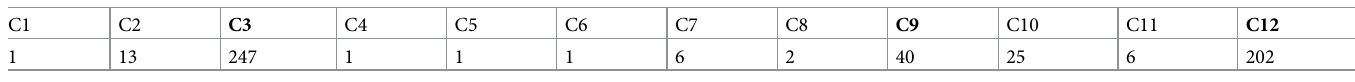
Fig 5. Scree plot for group 2. Barplot of the percentage of inertia explained by each of the MCA dimensions. The cumulative percentage of inertia explained is annotated on each bar. The 90% threshold corresponds to 22 MCA components which explain 88.7% of the inertia.